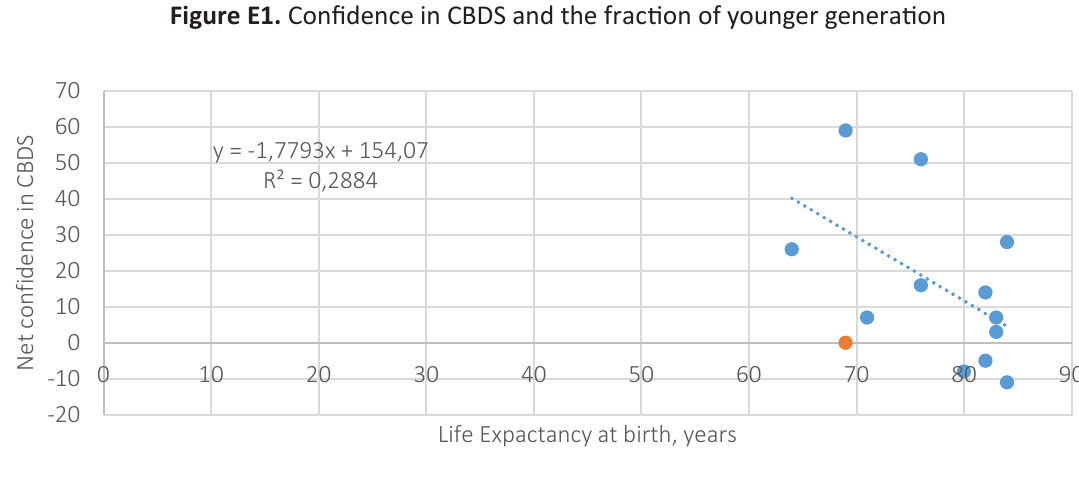
Figure Е2. Confidence in CBDS and life expectancy